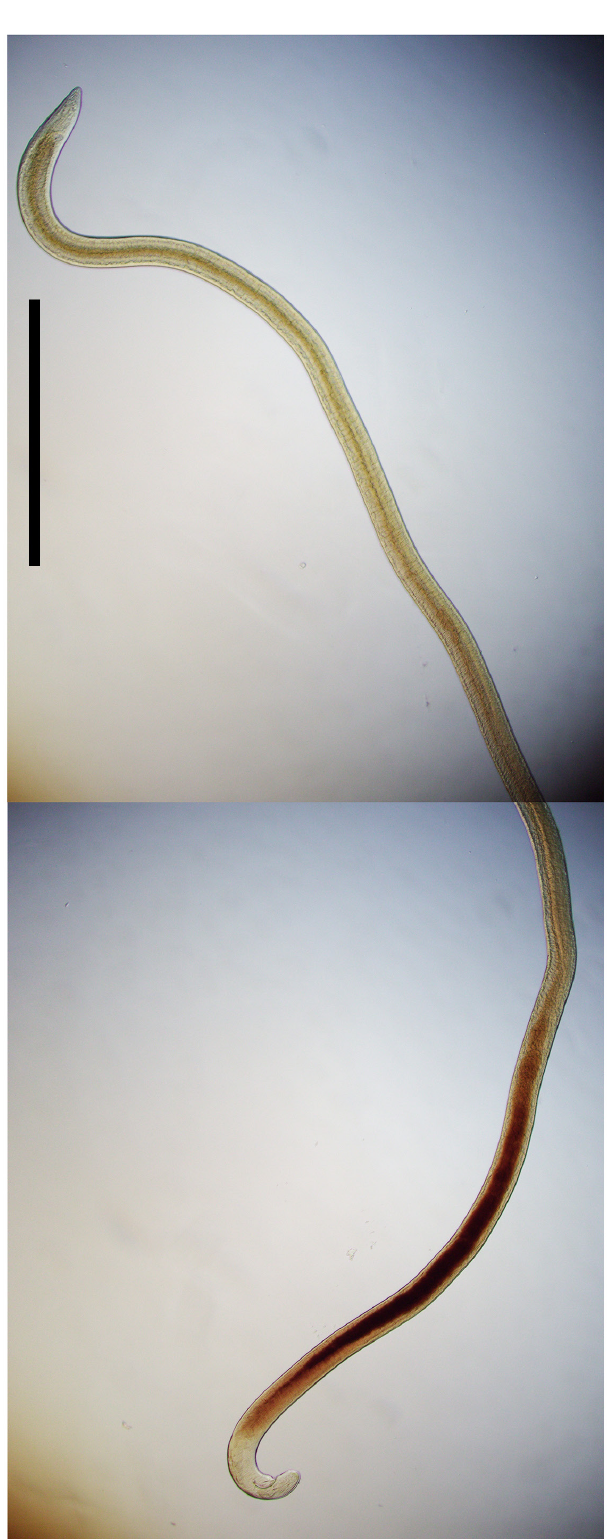
Fig. 9. Aulostomonema abyssum gen. et sp. nov. Composite light micrograph image of entire male, paratype (NIWA154912). Scale bar = 1000